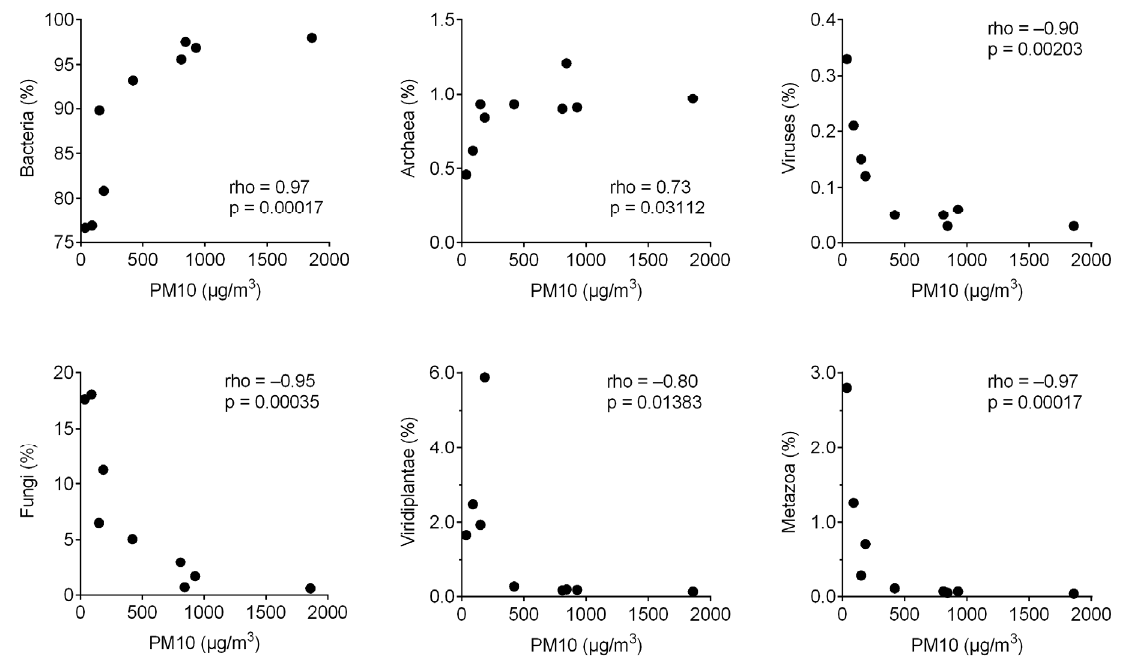
Figure 2. The relationships between the concentration of atmospheric particulate matter having an aerodynamic diameter smaller than 10 µ m (PM10) and the relative abundance of reads classified as Bacteria, Archaea, Viruses, Fungi, Viridiplantae, and Metazoa. Spearman’s rank-order correlation coefficient (rho) and the associated p -value (p) are reported in each panel.